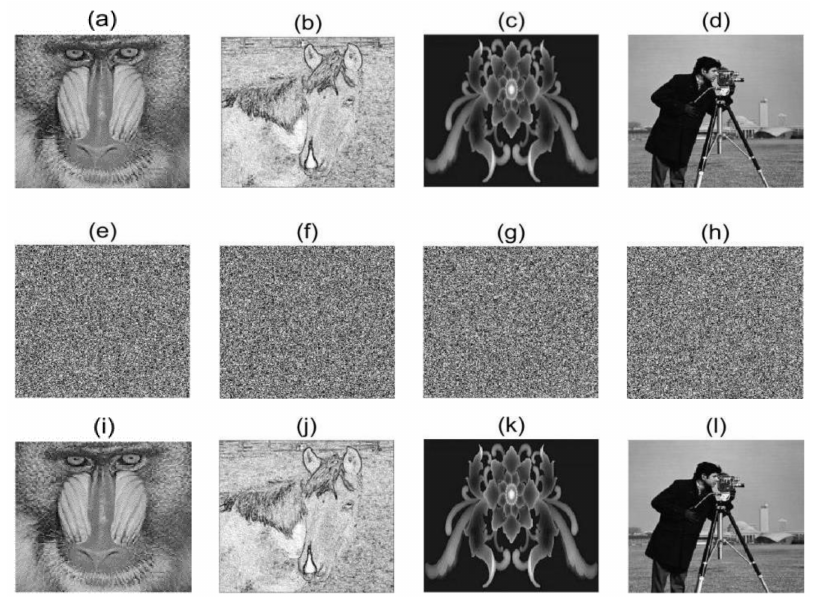
Figure 13. Encryption and decryption experiments ( a–d ) Plain-text images; ( e – h ) Encrypted images; ( i–l ) Decrypted images with correct